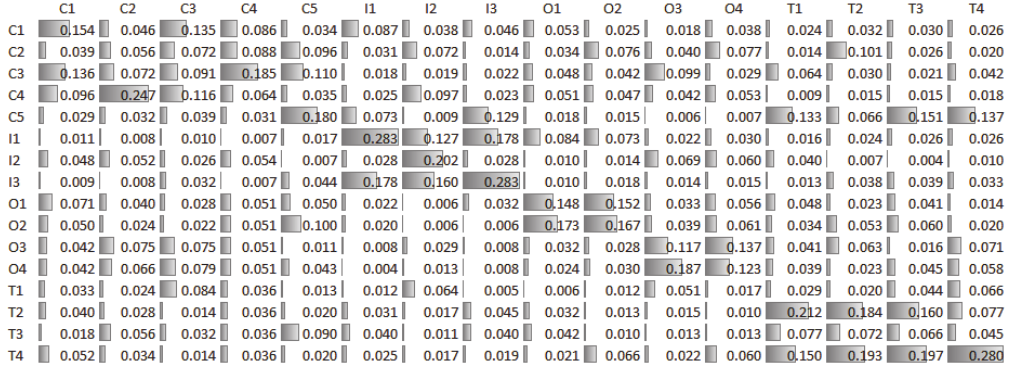
Fig. 6. Weighted Super Matrix of the Port